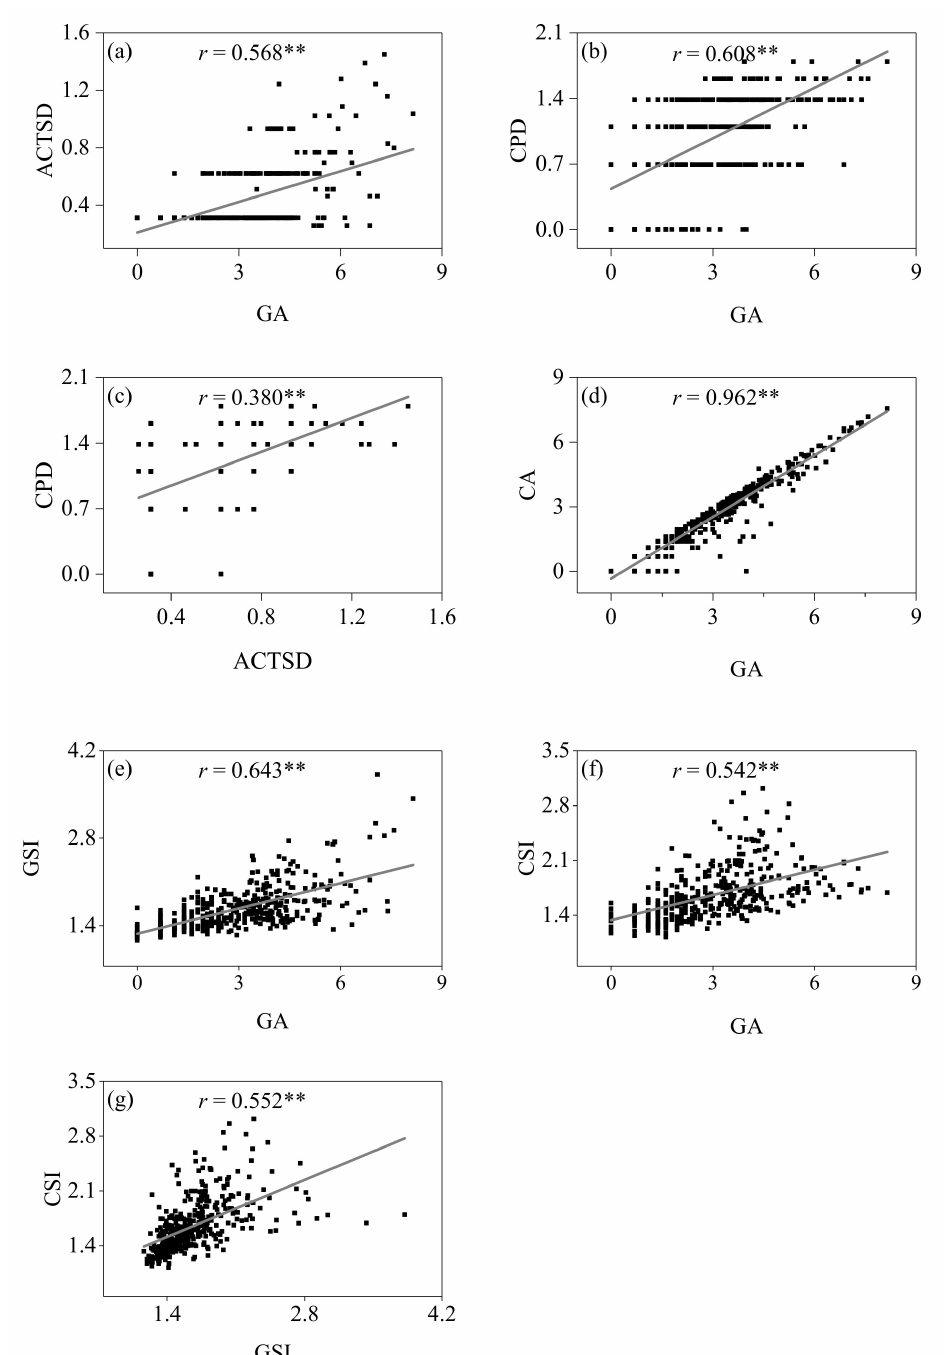
Figure 4. Relationships between GA with ( a ) ACTSD, ( b ) CPD, ( d ) CA, ( e ) GSI, and ( f ) CSI; the relationship between CPD with ( c ) ACTSD; the relationship between GSI with ( g ) CSI of each gap. ACTSD–autumn color-leaved tree species diversity; CPD–color-leaved patch diversity; CSI–color- leaved patch shape index; GSI–gap shape index; CA–color-leaved patch area; GA–gap area. Correla- tions ( r ) are indicated on the figure: ** indicates p <